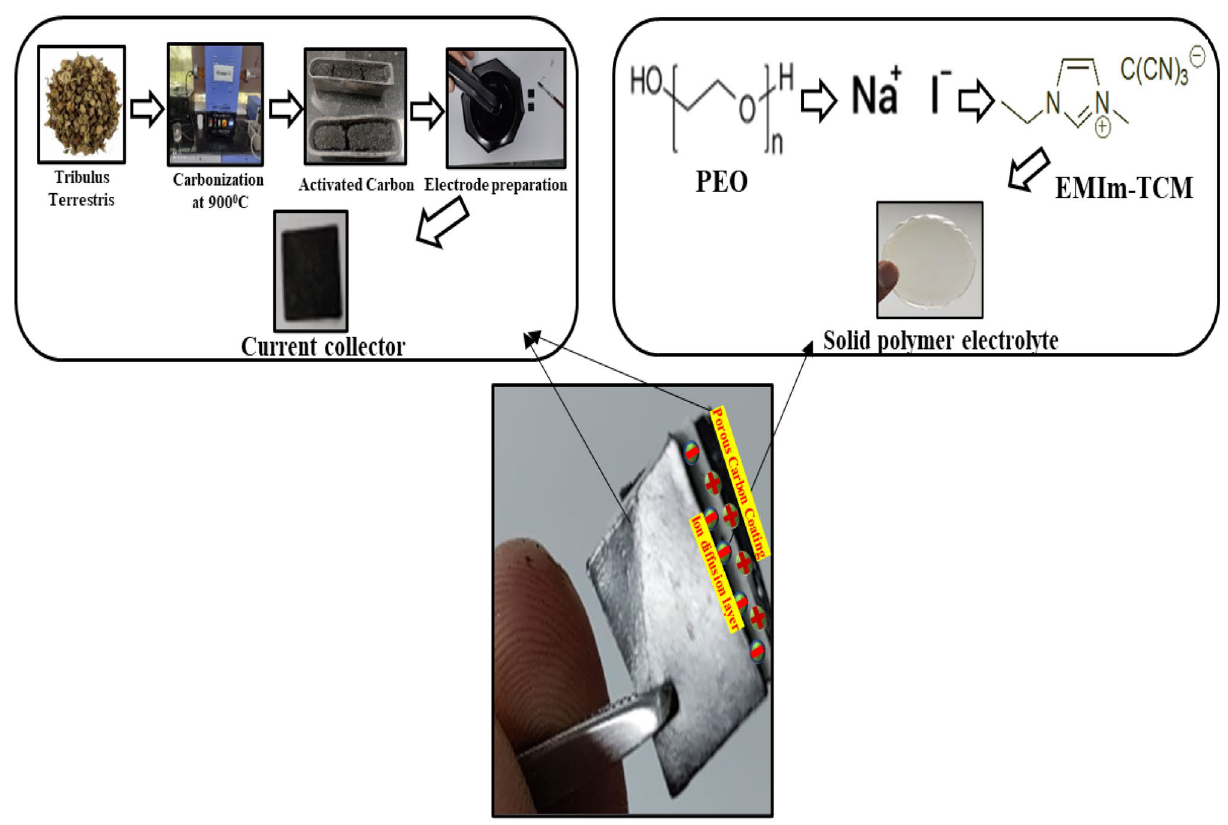
Fig. 2 Fabrication of EDLC device